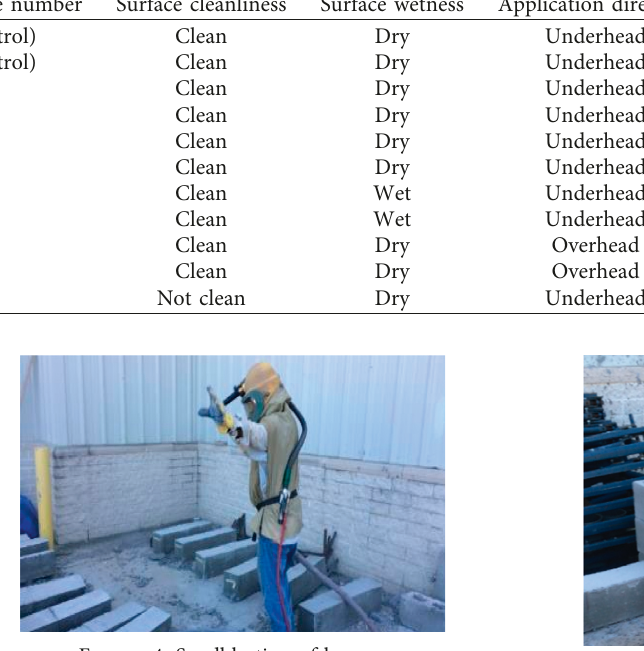
Figure 5: Setup for upward application of